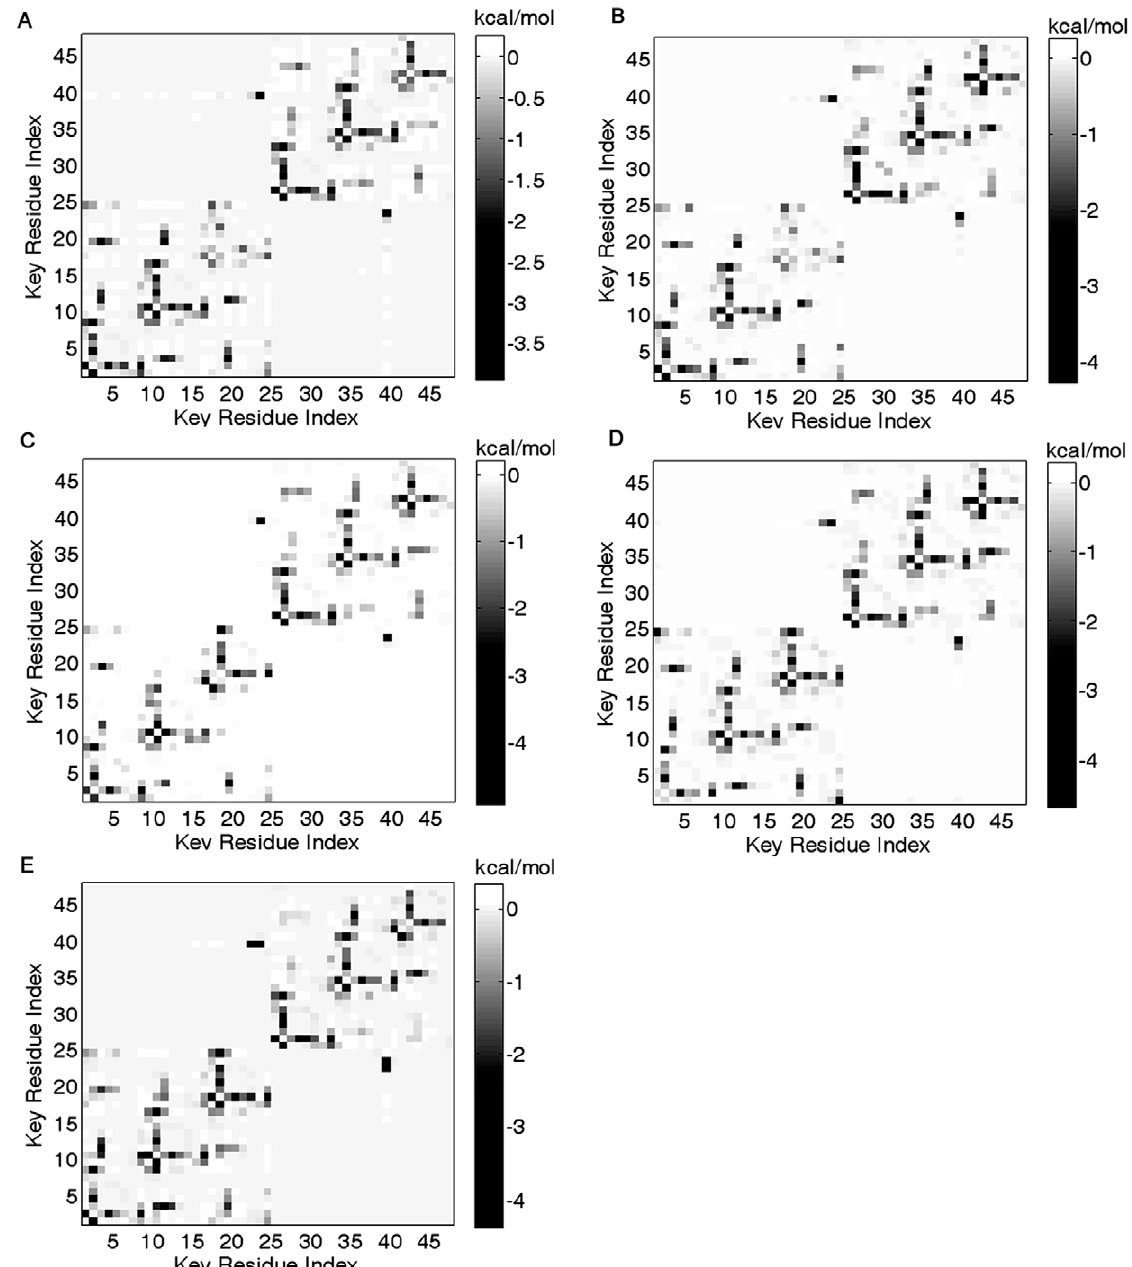
Figure 5. The potential energies of residue interactions between key structural residues for 2aaib(A), 1abrb(B), 1ggpb(C), 1m2tb(D) and 1hwmb(E). The key structural residues are arrayed along two axes according to their orders in the sequence. The magnitude of the interactions is indicated by the colorbar.